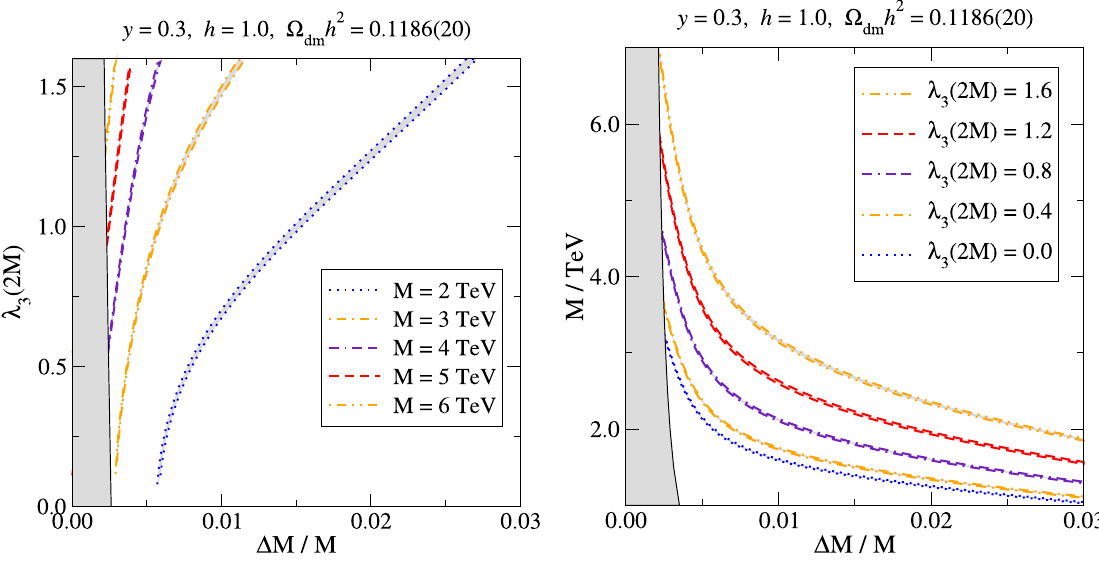
Figure 4 . Left: values of the coupling λ 3 (2 M ) needed for producing the correct dark matter abundance. In the shaded region, bound states of coloured scalars are lighter than scattering states of two Majorana fermions. Right: a corresponding plot for the dark matter mass scale M /TeV. Note that h has two different meanings here, a quark Yukawa coupling and a rescaled Hubble rate.